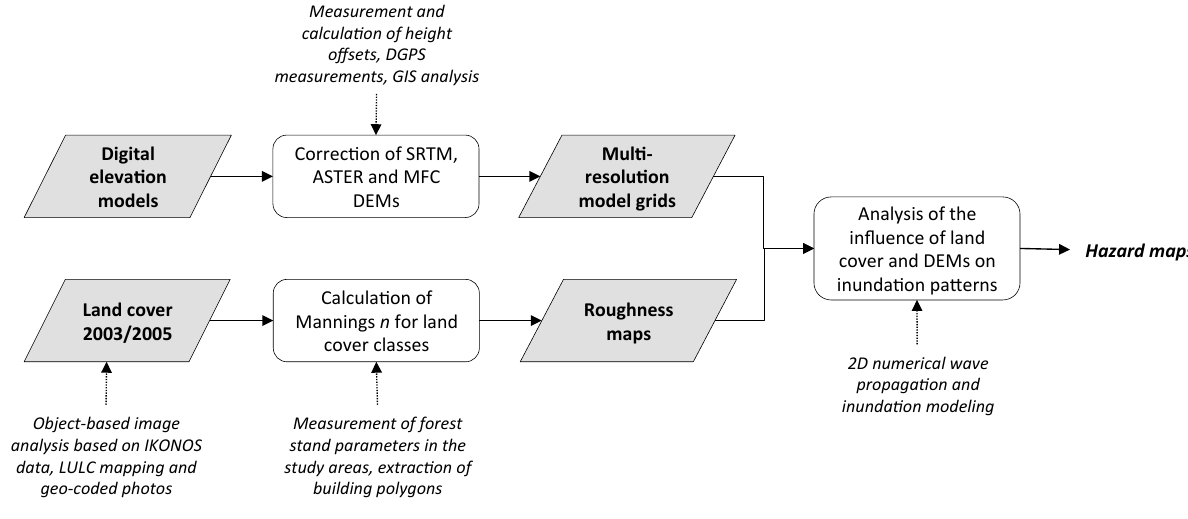
Fig. 3. Workflow and remote sensing application in the hazard analysis. values for every LULC class multiplied with the ground cov- erage were added to the LULC classification in a GIS. The final LULC map was then converted into a raster, resampled and eventually subtracted from the SRTM data according to Eq. (1). Finally, the DTM-raster was smoothed using a fill- filter algorithm (ESRI